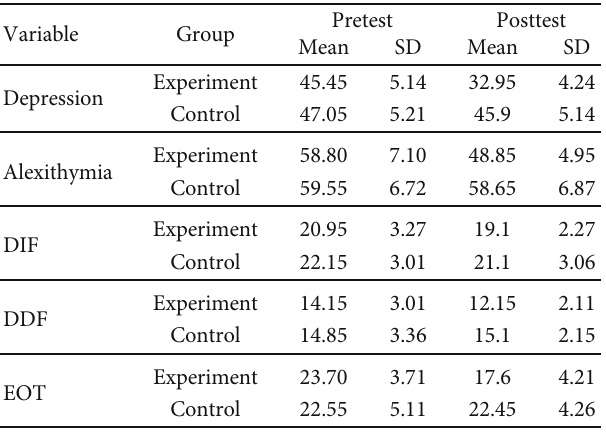
Table 2: Descriptive statistics of research variables in control and experimental groups in pretest and posttest.